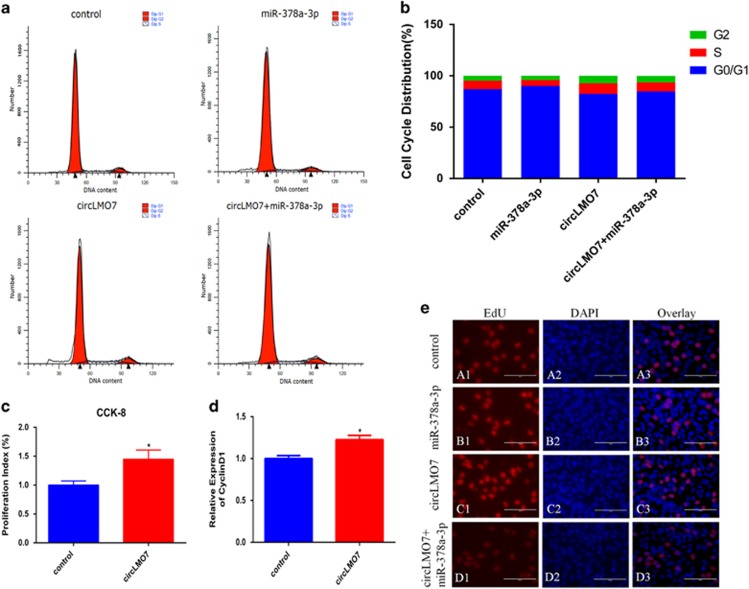
circLMO7 promotes the proliferation of bovine primary myocytes. (a, b) Bovine primary myocytes were transfected with pcDNA-circLMO7 and/or miR-378a-3p mimic, and cell phases were analyzed by flow cytometry. (c) Cell proliferation was assessed using the cell counting kit-8 (CCK-8) assay. (d) mRNA of the proliferation marker CyclinD1 was quantified using qPCR. (e) Cell proliferation indices were assessed after treatment with 5-Ethynyl-2′-deoxyuridine (EdU). The scale bar represents 200 μm. Data are presented as means±S.E.M. for three individuals. *P<0.05